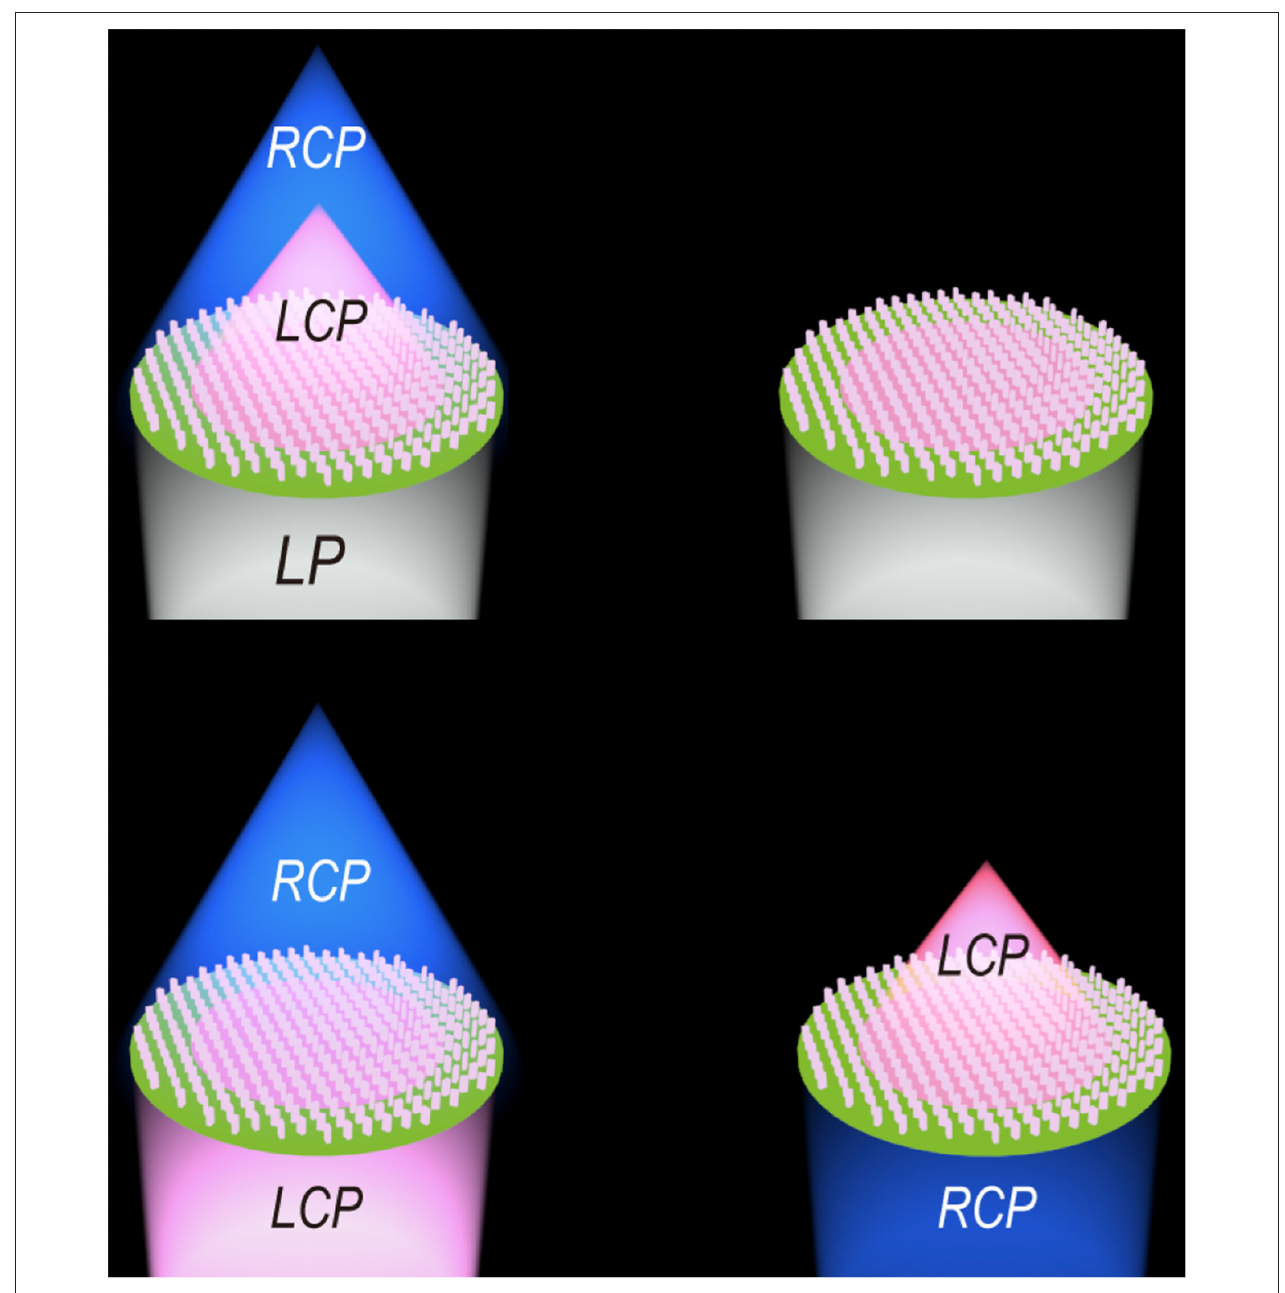
FIGURE 1 | Working principle diagram. The two pictures on the top show the wavefront reshaping pictures at different temperatures when LP light is incident, and the two pictures on the bottom are the wavefront reshaping pictures under LCP and RCP light incidents.